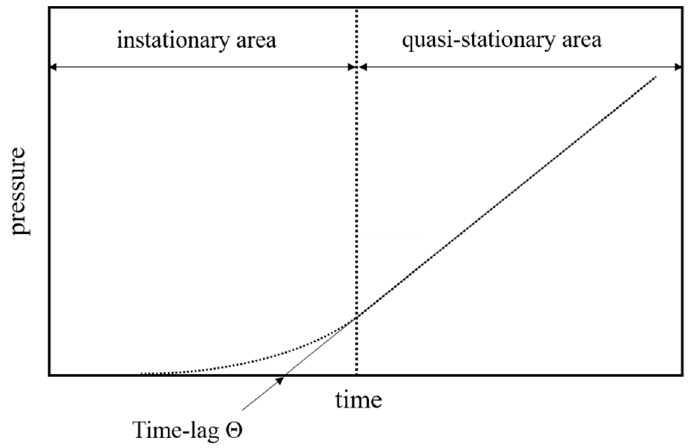
Figure 1. Exemplary depiction of a time–pressure curve obtained from the time-lag measurement.